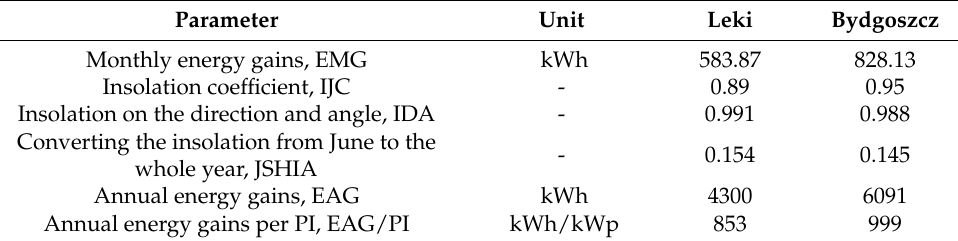
Table 3. Energy production correction factors and annual energy gains.